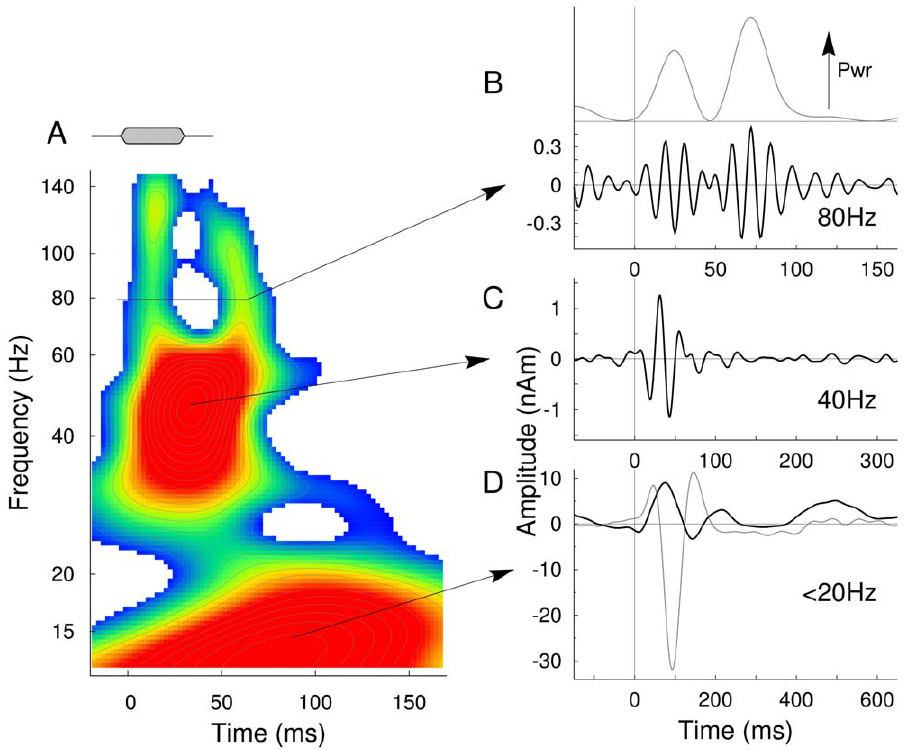
Figure 2. Overview of the types of auditory evoked responses. A : The time-frequency map of inter-trial coherence in the responses to the 34- ms no-gap stimulus shows three main effects: the low frequency response below 20 Hz, the transient gamma band response at 40 Hz, and high- gamma responses at 80 Hz and above. B : The time series of activity in the high-gamma band shows two bursts of oscillations, which are expressed in two peaks in the time series of the signal power (upper trace). C : The transient 40-Hz response is likely equivalent to the middle-latency response. D : The low frequency response (black) shows predominantly a positive peak resembling a P1m response. The N1 m -P2 m response is strongly reduced because of fast stimulus repetition. For comparison the response to same stimuli at longer SOA (1500ms) is shown as gray line.